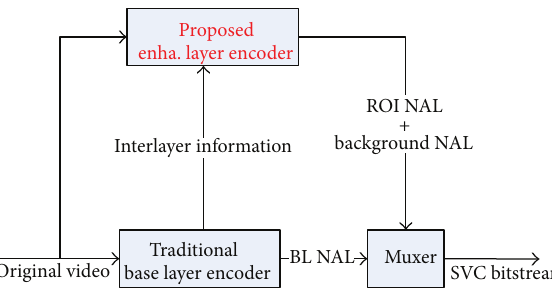
Figure 2: Architecture of ROI enabled SVC coding